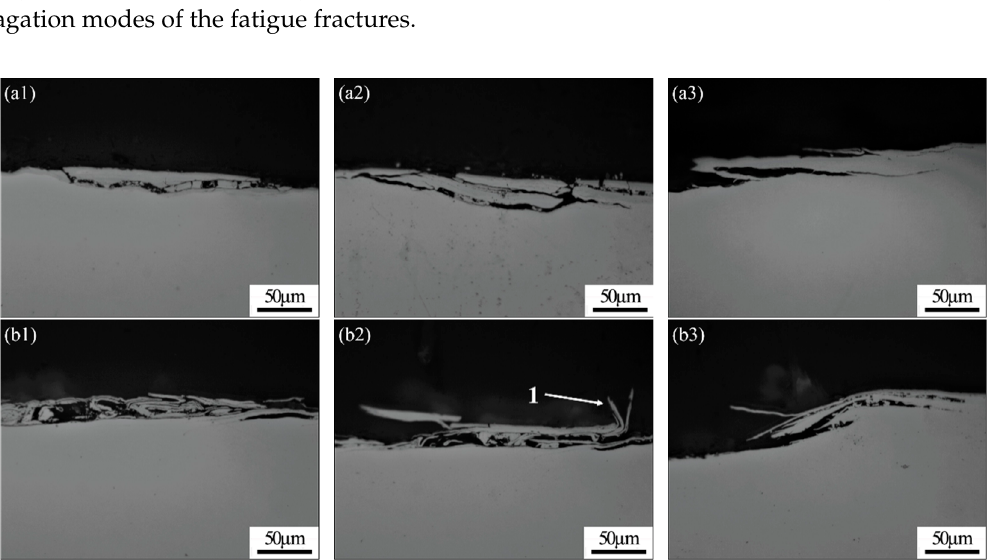
Figure 7. Cross-sectional micrographs of the steels after wear for 120 min. ( a1 – a3 ) Steel tempered at